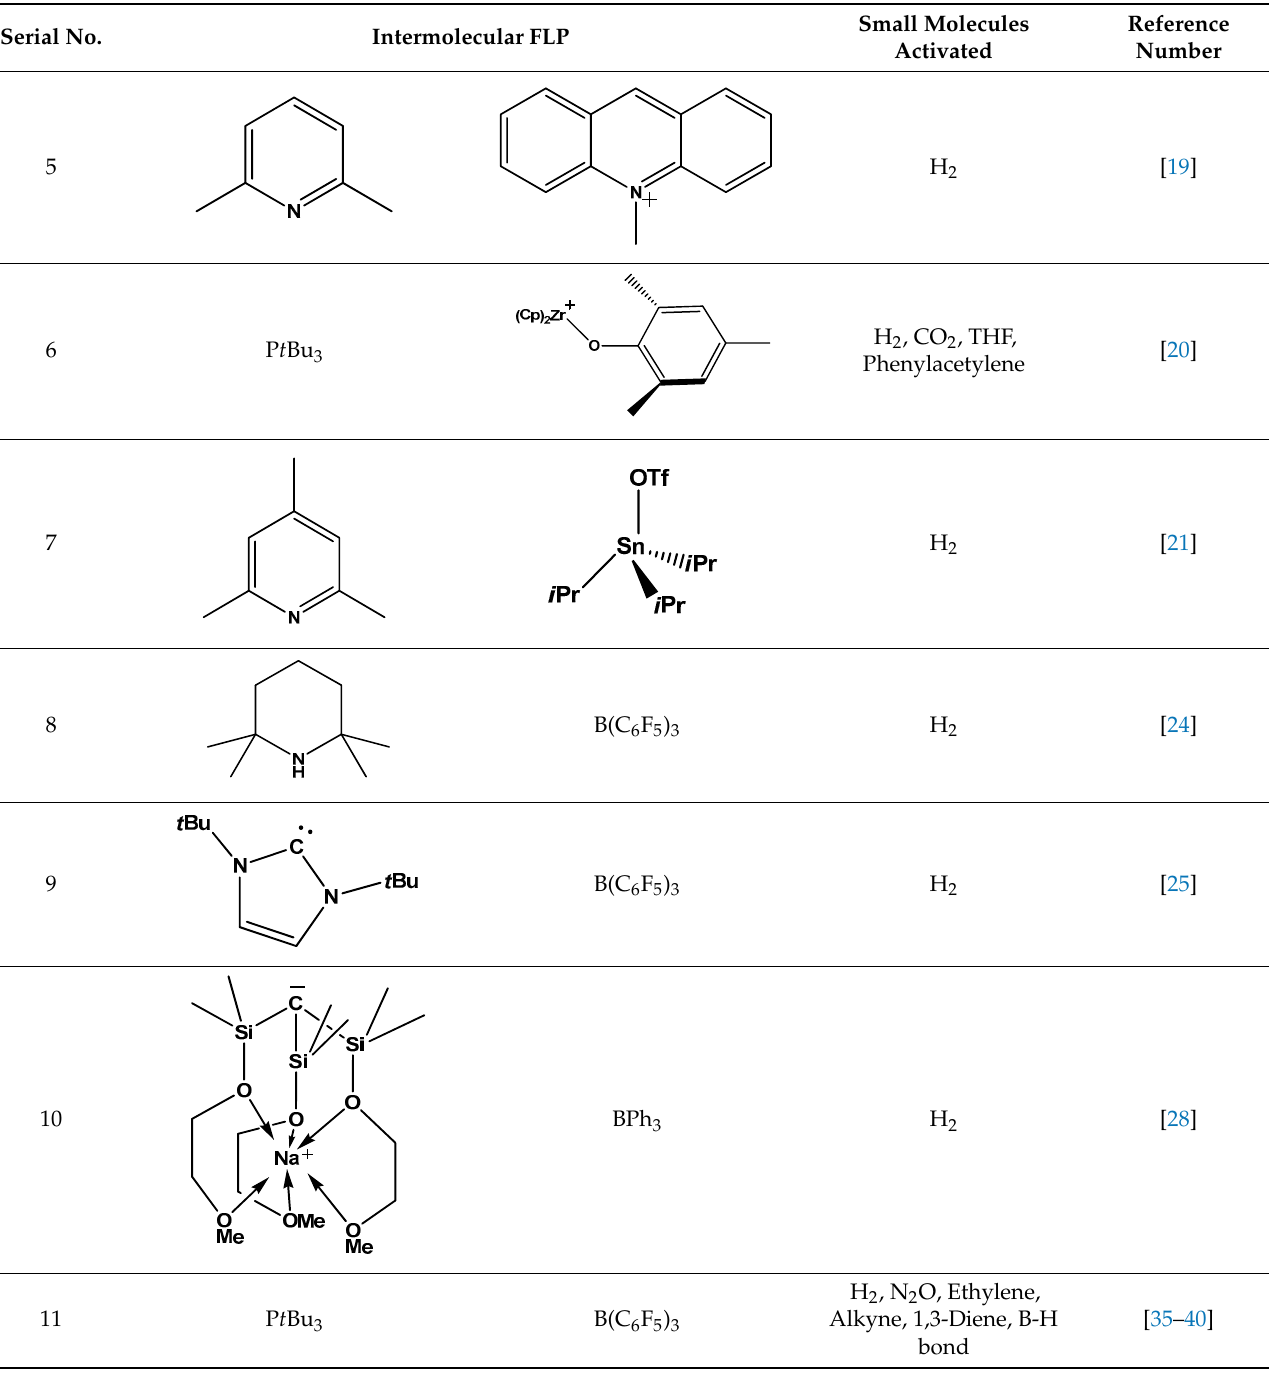
Table 2. Structures of some intramolecular FLPs and their role.